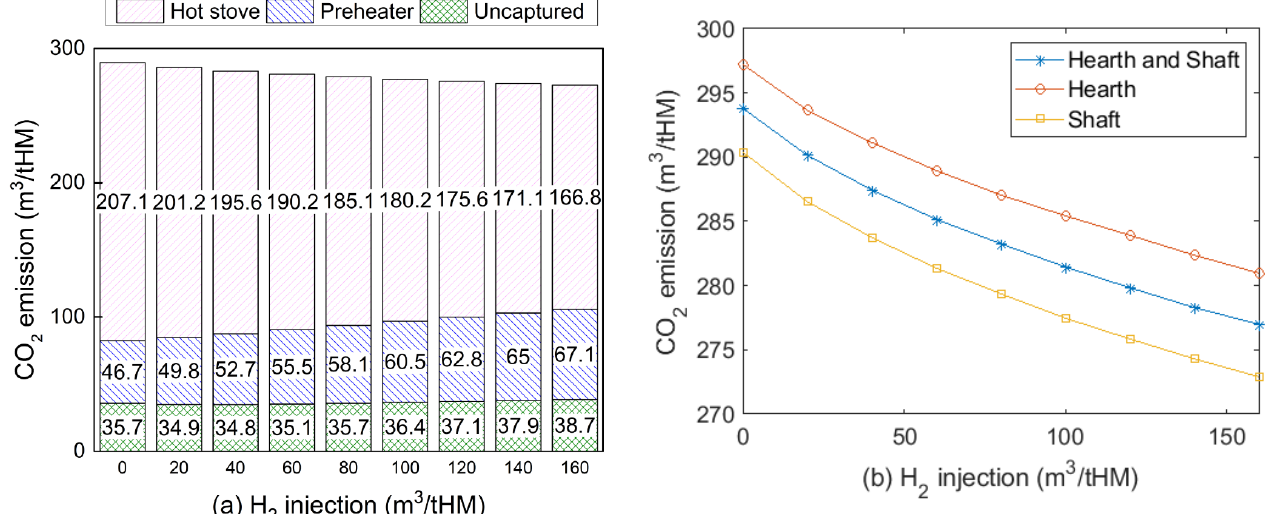
Figure 11. CO 2 emissions of iron-making process with H 2 injection ( a ) with different CO 2 emission sources for shaft injection case; ( b ) at different injection positions (injection temperature for shaft and hearth was 900 and 1250 °C, respectively).